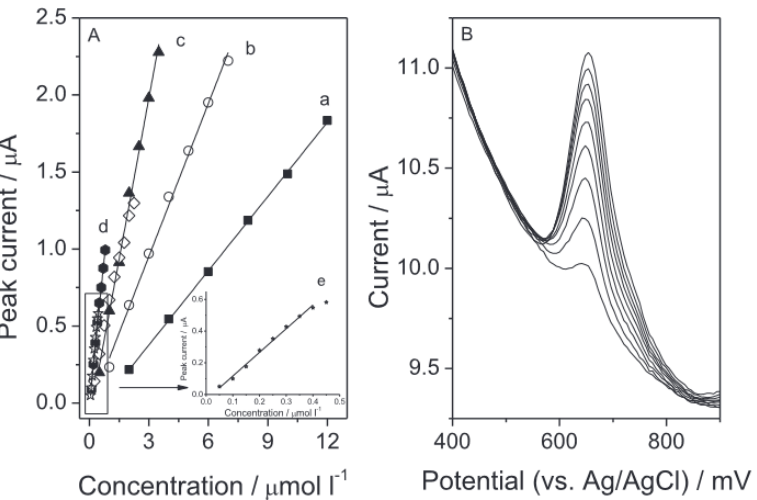
Figure 2. Melatonin calibration graphs ( A ) with corresponding voltammograms ( B ) measured on a glassy carbon electrode modified with carbon black [213]. The following curves in picture A stand for preconcentration times: a: 0 s, b: 3 s, c: 6 s, d: 10 s and e: 20 s, measurements carried out in the 0.1 mol L − 1 phosphate buffer pH 6.2. Reprinted from Carbon black as a glassy carbon electrode modifier for